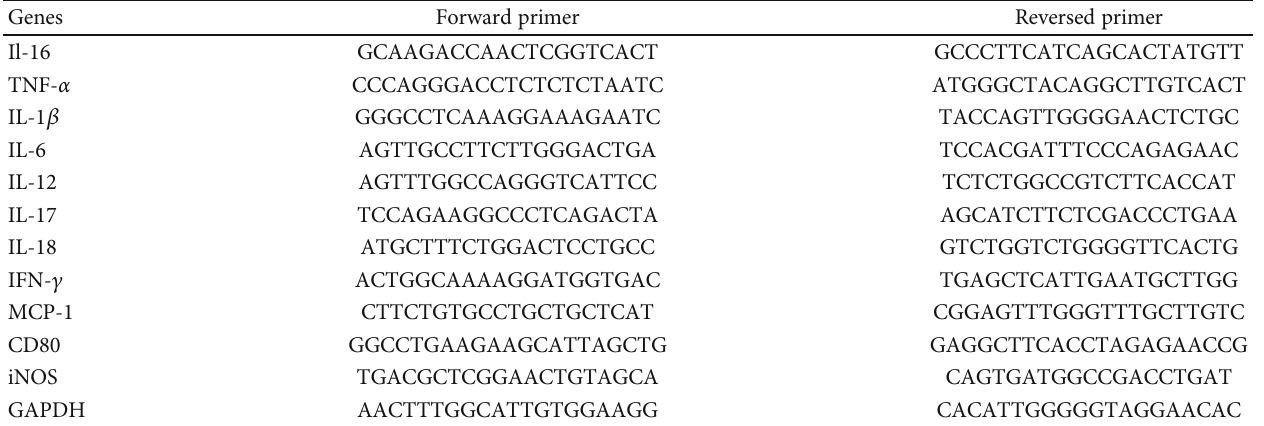
Table 1: Real-time PCR primer